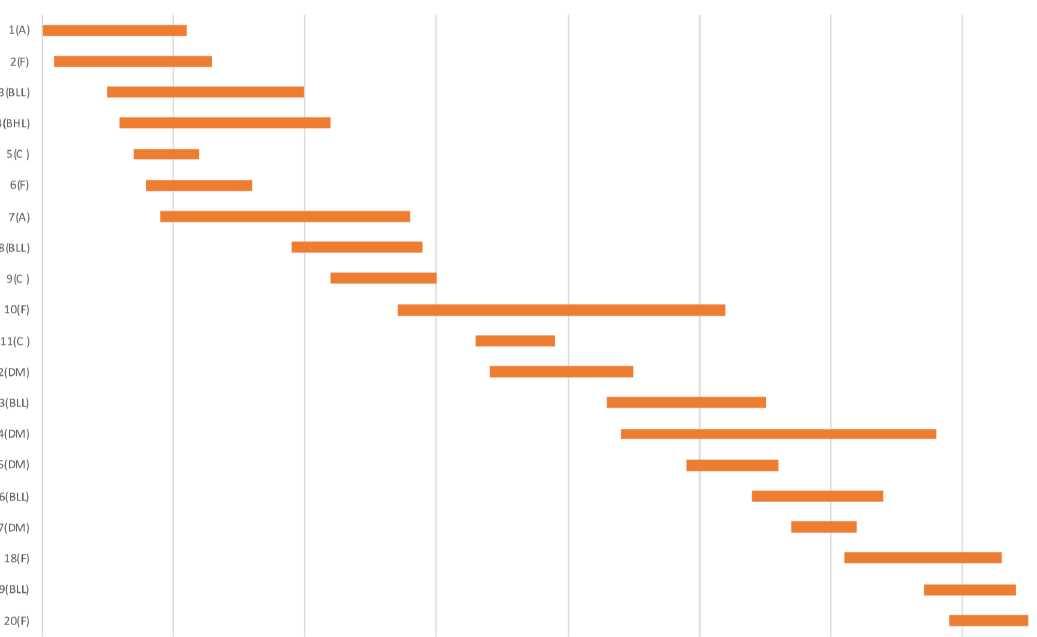
Figure 11. Gantt diagram of Scenario B when CLARISSE is not active and, consequently, the interferences are not avoided. The length of diagram corresponds to the workflow makespan with a value of 13.256